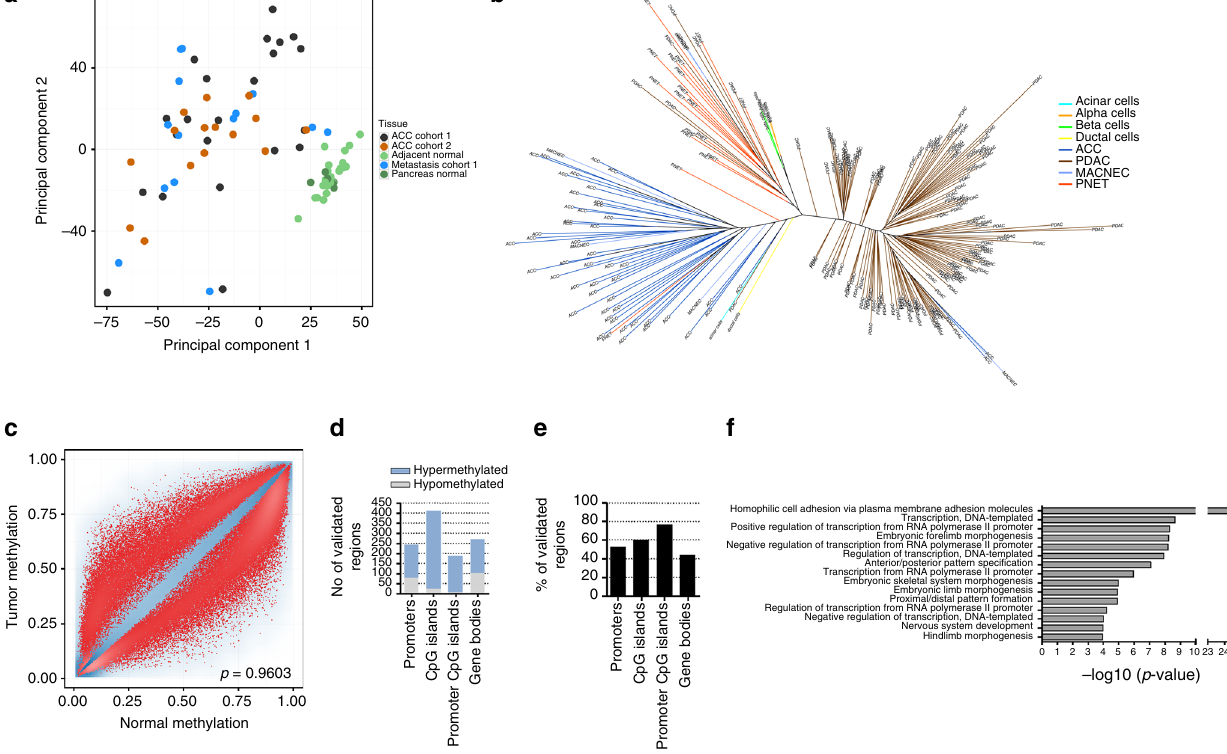
Fig. 2 ACC display a unique methylome and many recurrent differentially methylated regions. a Principal component analysis of all CpG sites of cohort 1 and cohort 2. b DNA methylation phylogenetic tree, including ACC, MACNEC, PNET, PDAC, and sorted pancreatic cells. c Methylation scatterplot of all CpG sites on the 450K array in cohort 1 reveal massive differential methylation comparing all primary tumors versus all normal tissues. (red: sites above the rank cutoff, i.e., considered signi fi cant, blue: transparency corresponds to density of sites.). d Differential methylation de fi ned by the rank cutoff in regulatory regions identi fi ed in cohort 1 and validated in cohort 2. e Validation rate of regions identi fi ed in cohort 1 and validated in cohort 2. f GO enrichment analysis displaying enriched pathways of the differentially methylated regions (input: regions of cohort 1 con fi rmed in cohort